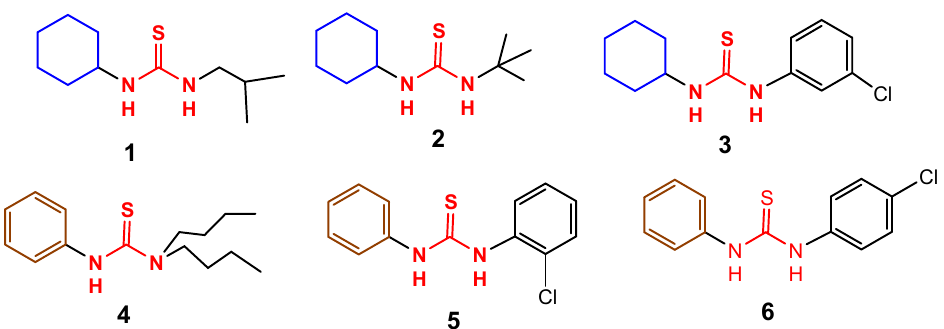
Figure 1. Structure of unsymmetrical thiourea derivatives, 1-cyclohexyl-3-( iso -butyl)thiourea ( 1 ), 1-cyclohexyl-3-( tert -butyl)thiourea ( 2 ), 1-cyclohexyl-3-(3-chlorophenyl)thiourea ( 3 ), 1-phenyl-3-(1,1-dibutyl)thiourea ( 4 ), 1-phenyl-3-(2-chlorophenyl)thiourea ( 5 ) and 1-phenyl-3-(4-chlorophenyl)thiourea ( 6 ) used in this study.